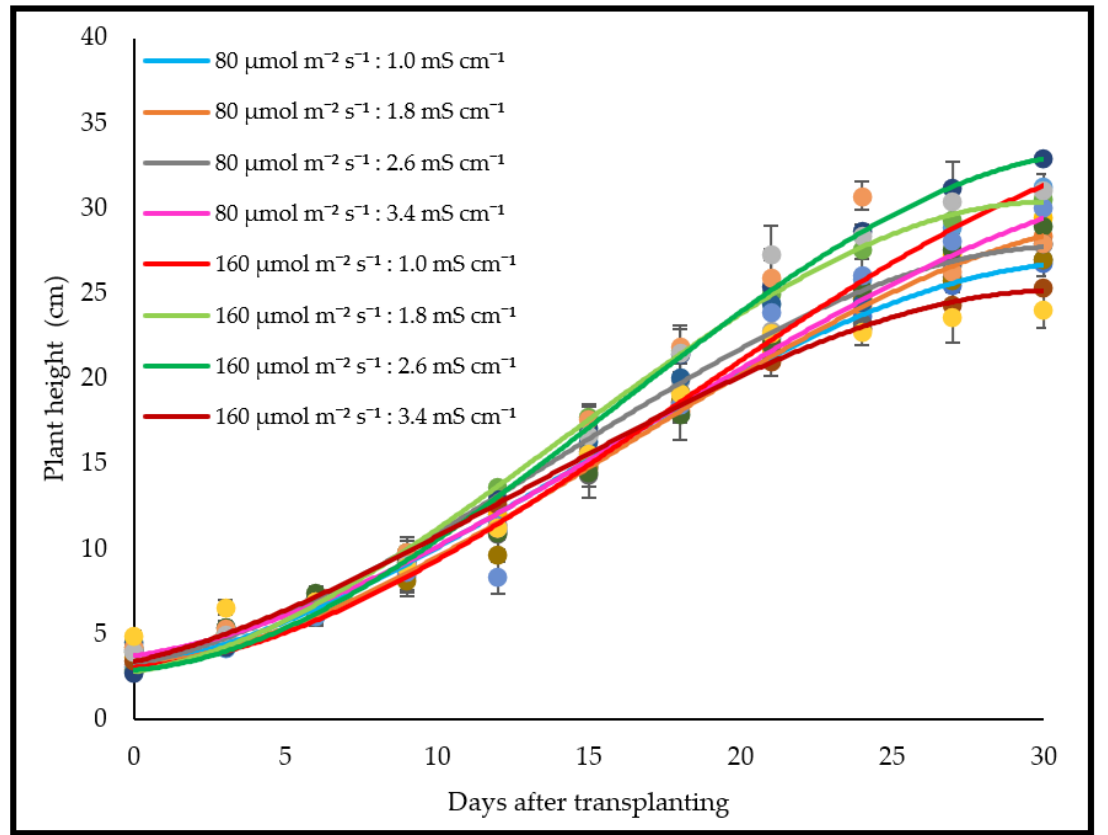
Figure 1. Plant height of lemon basil for a growing duration of 30 days under different LEDs and nutrient solution